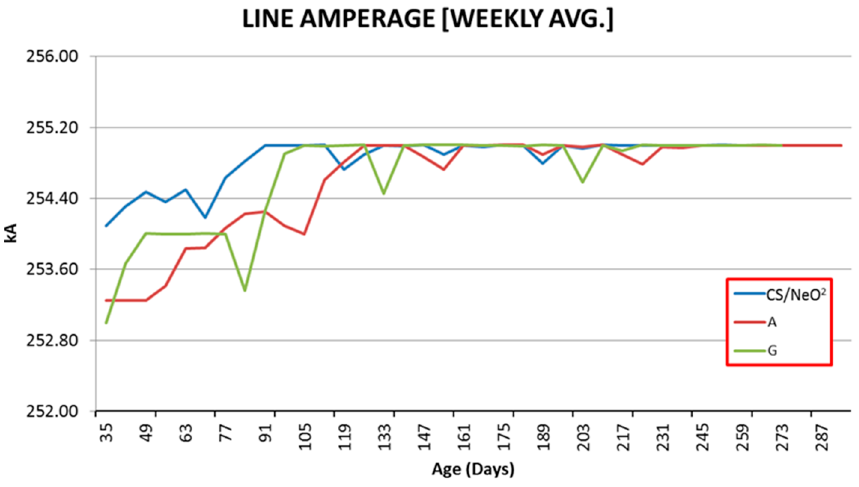
Figure 9. Line amperage average weekly values (in kA) for pots with different pastes.